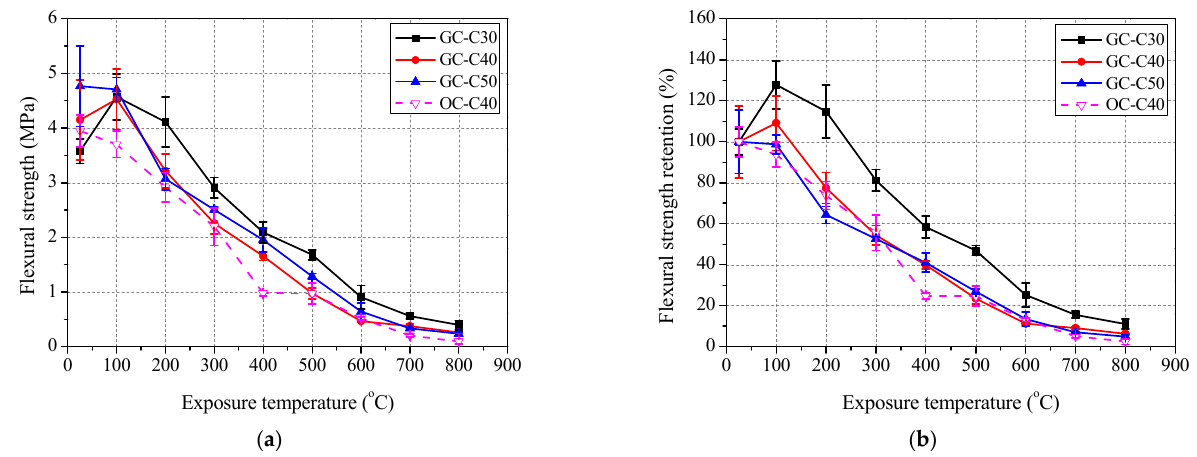
Figure 8. Residual splitting tensile strength of concrete after exposure to elevated temperature: ( a ) splitting tensile strength and ( b ) retention.